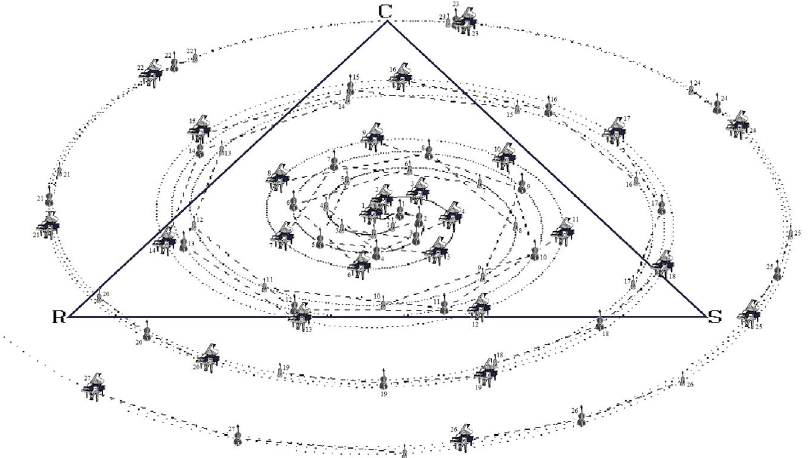
Figure 22: Triangle and Spiral used for the composition of 1981 . See also reference (Barlow,